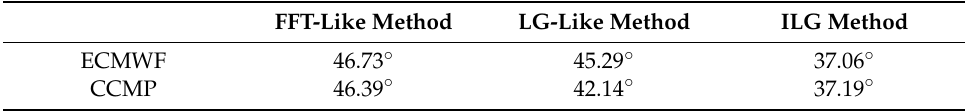
Table 3. The RMS differences between retrieved results of each method of the images corrupted by the speckle noise and wind directions obtained from the ECMWF (or CCMP) data.